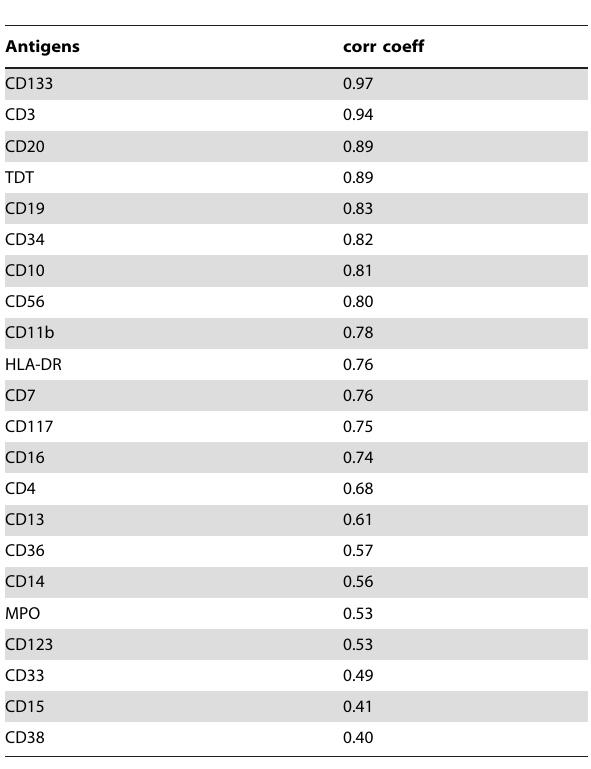
Pearson’s correlation coefficient between nCounter signal intensity and percentage of positive cells measured by flow cytometry. Twenty-two different antigens were analyzed in seventy-three samples (11 normal bone marrow, 5 normal peripheral blood, 8 sorted cell populations, 45 acute leukemia, 2 CLL, and 2 CML). corr coeff . 0.302 are statistically significant with p ,